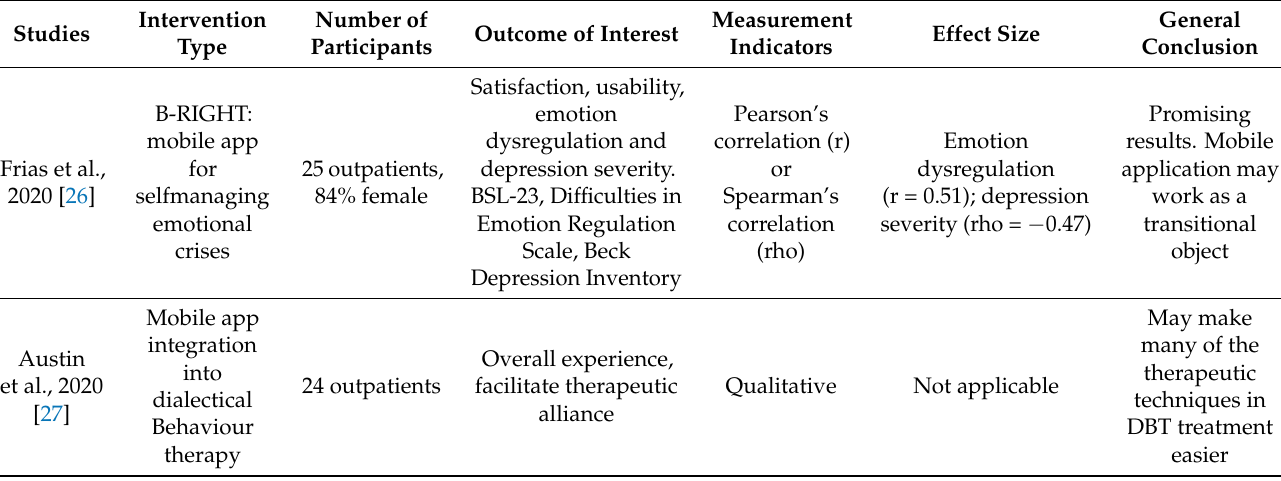
Figure 1. Flowchart of the study selection process. Table 1. Details for the studies included.